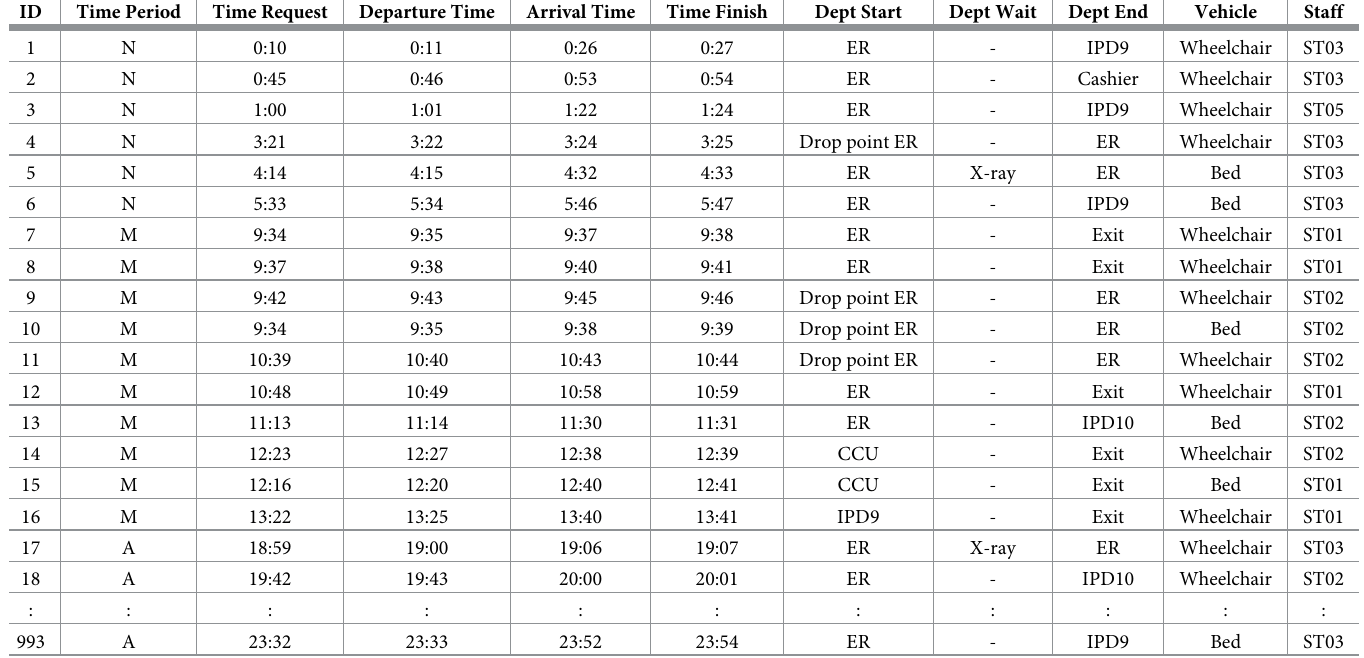
Table 3. Schedule of internal arrival